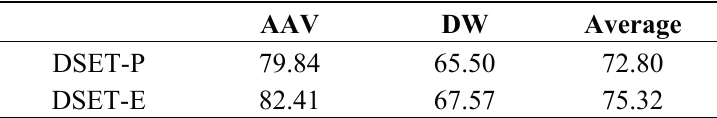
Table 5. Final data fusion accuracies (average,